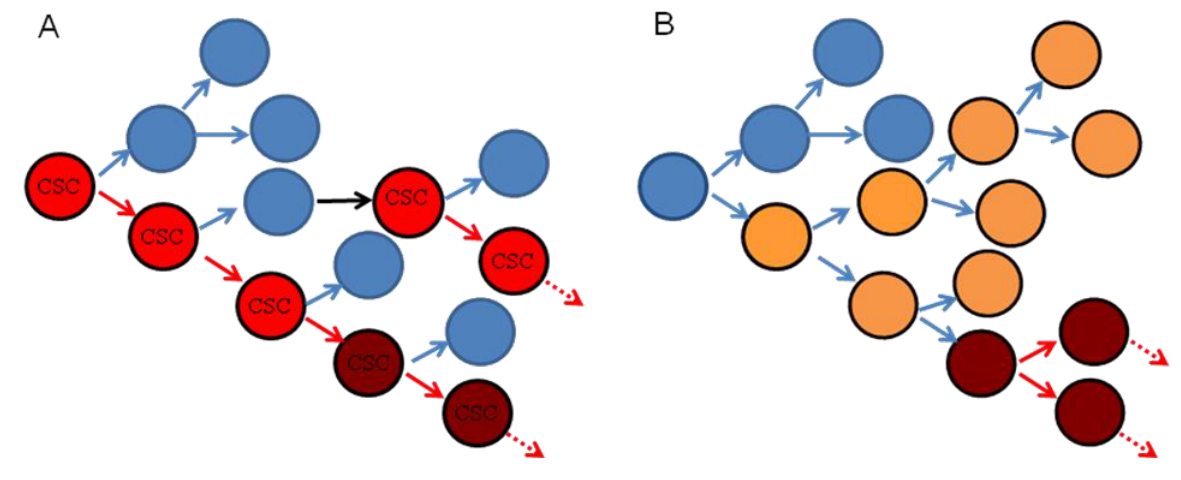
Figure 1. Cancer heterogeneity models. ( A ) Hierarchical model of Cancer Stem Cell (CSC). The CSC (in red) undergoes a division to give rise to a differentiated daughter cell (blue) and another CSC (red, self renewal depicted by red arrow). The CSC by virtue of its infinite proliferative potential will continue to divide as above (dotted arrow). The differentiated cell may undergo a few divisions before terminal differentiation or senescence or cell death as the case may be. The CSC may undergo clonal evolution and acquire even greater tumorigenicity and/or chemoresistance and/or radioresistance (brown). and acquire tumorigenicity (black arrow) and be converted to a CSC. ( B ) Clonal Evolution model. Normal cells (blue) acquire mutations stochastically (yellow), and over successive divisions and due to accrual of several mutations these cells become transformed (red) and/or acquire chemo- and/or radio-resistance and can divide indefinitely (dotted